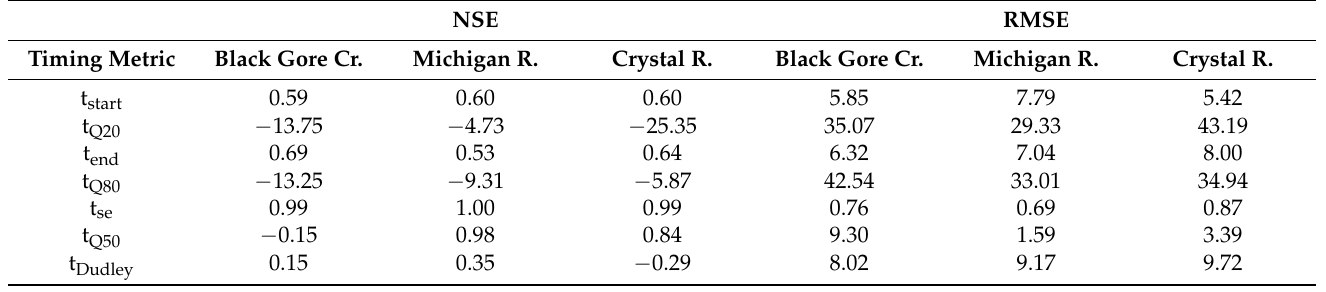
Table 1. Root-mean-square error (RMSE) and Nash–Sutcliffe efficiency (NSE) for each streamflow timing metric, as well as the baseflow factors used in developing the t start and t end .